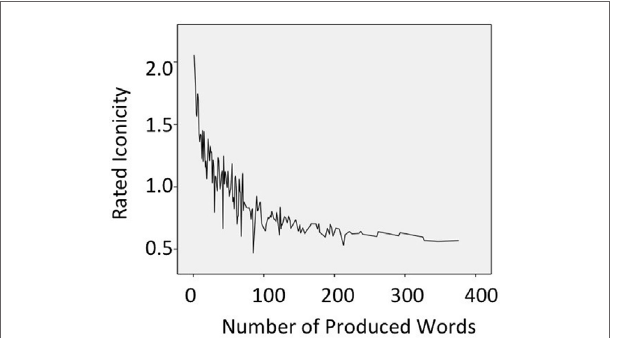
FigUre 4 | Mean iconicity values of produced versus understood words as a function of the six groups with an increasing number of words in their produced or understood vocabulary . No results are shown for Group 1 produced words because these children did not produce